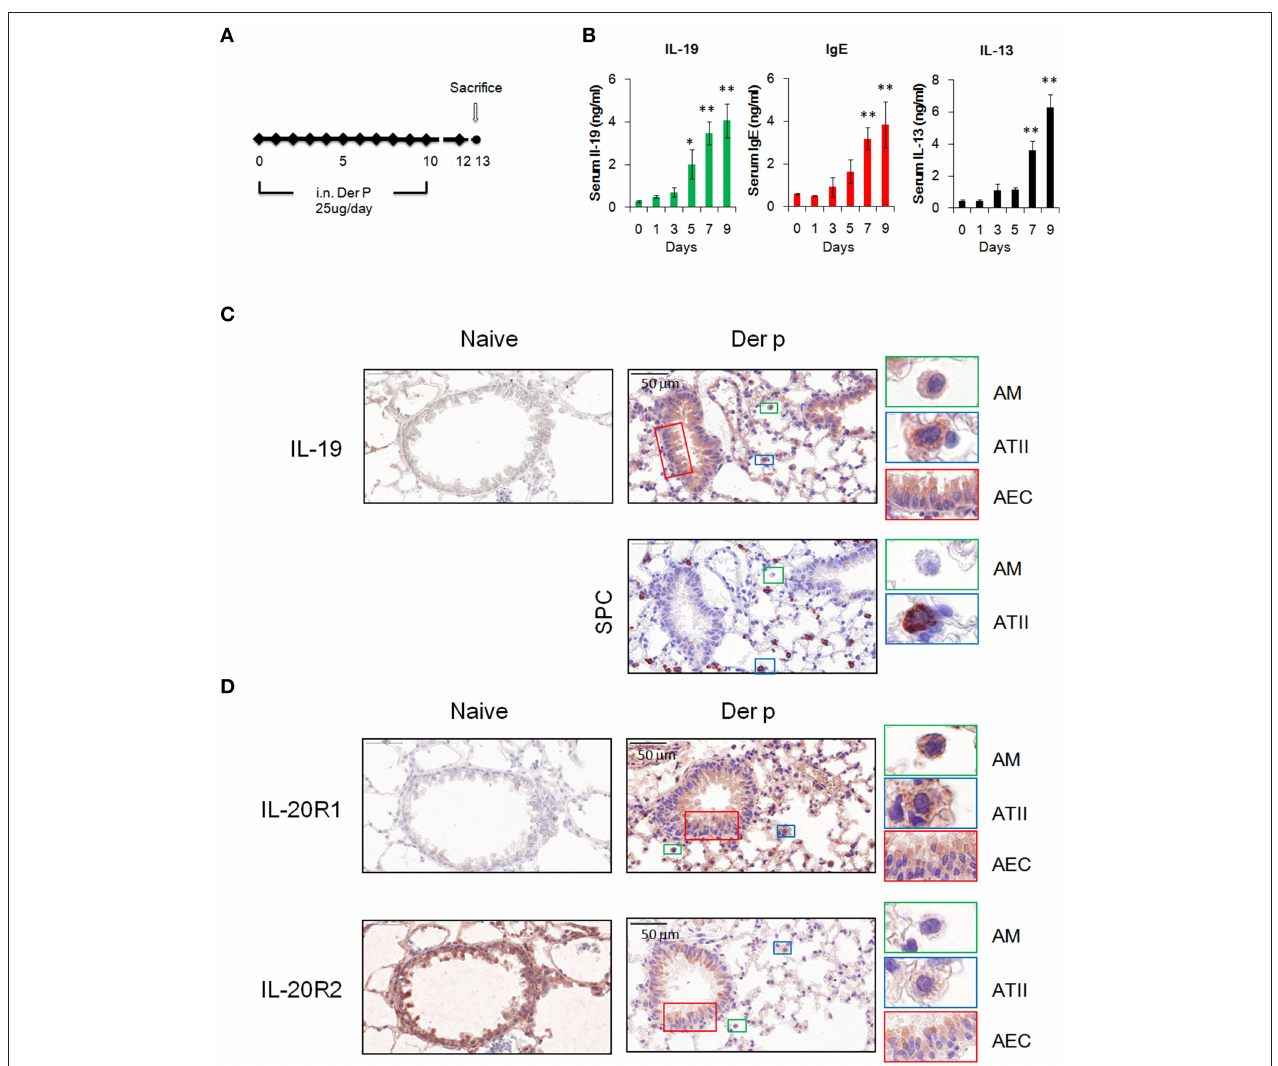
FIGURE 3 | Expression of IL-19 and IL-19 receptors in lung tissues. (A) C57BL/6 mice were intranasally (i.n.) challenged with Der p extract (25 µ g/mouse/day) for 10 days to induce asthma. (B) Dynamic serum levels of IL-19, IL-13, and immunoglobulin E (IgE) in Der p -sensitized mice ( n = 5). * P < 0.05, ** P < 0.01 compared with day 0 control by one-way non-parametric ANOVA. (C) Lung tissues were collected on day 13 and paraffin-sectioned for IHC staining for IL-19. Detection of the expression of surfactant protein C (SPC) in adjacent slide was used as marker for type II alveolar cells. (D) IHC staining for the expression of IL-20R1 and IL-20R2 with specific antibodies. Nuclei were counterstained with hematoxylin. Bars represented 50 µ m. AM, alveolar macrophages; ATII, type II alveolar cells; AEC, airway epithelial cells.